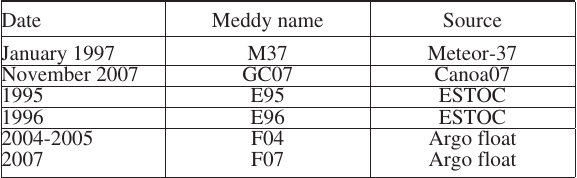
Table 1. – Summary of the meddies analysed, with their dates and the data